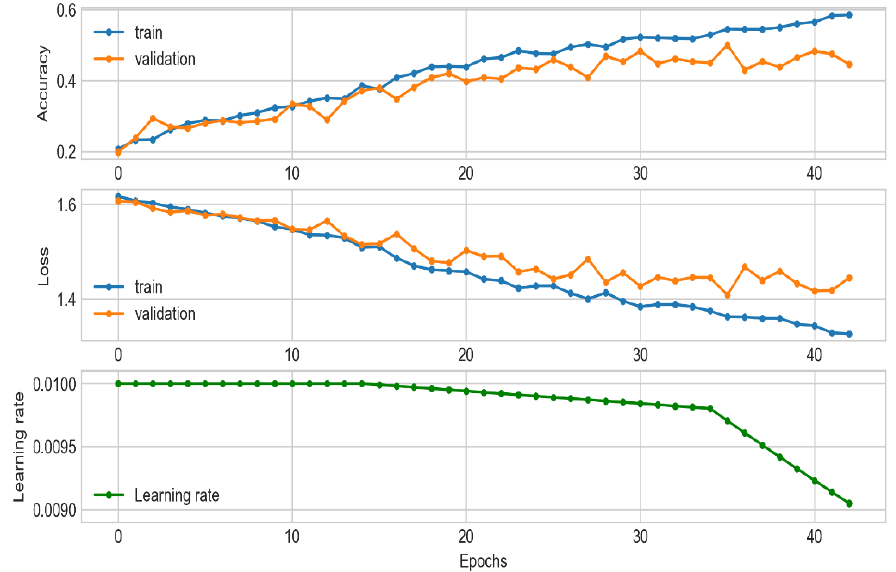
( d ) ( e ) Figure 4. Chest X-rays (CXRs) of the five different lung diseases used in this work: ( a ) atelectasis; ( b ) cardiomegaly, ( c ) consolidation, ( d ) edema; and ( e ) pleural effusion. For the training process, we set up the training for 100 epochs, we used the adaptive